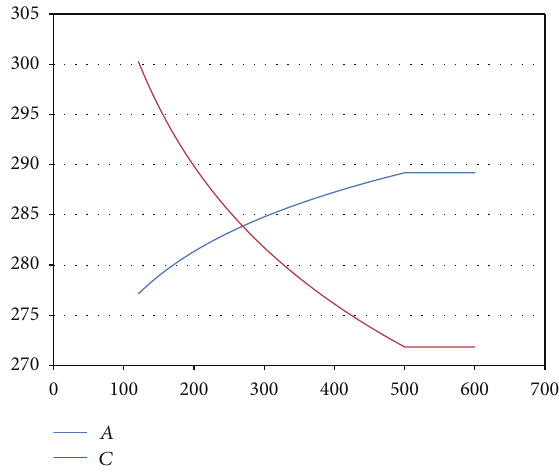
Figure 1: Set-up cost ( 𝐴 ) and unit production cost ( 𝐶 ) against production rate ( 𝑃 ) for 𝐷 = 120 , 𝑃 max = 500 , 𝐴 0 = 240 , 𝐶 0 = 420 , 𝜀 = 0.07 , and 𝜓 = 0.03 .